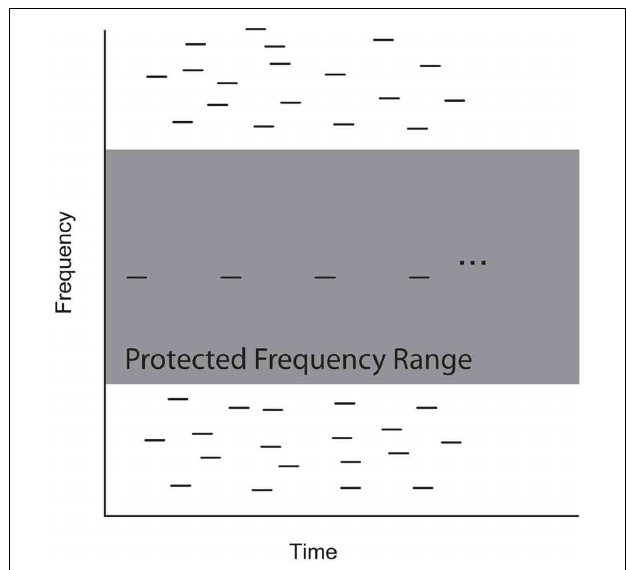
FIGURE 5 | In informational masking experiments, presenting a series of fixed-frequency target tones in the midst of a multi-tone masker stimulus can prevent awareness of the target, even when the masker tones are prevented from overlapping in frequency with the target by using a protected frequency